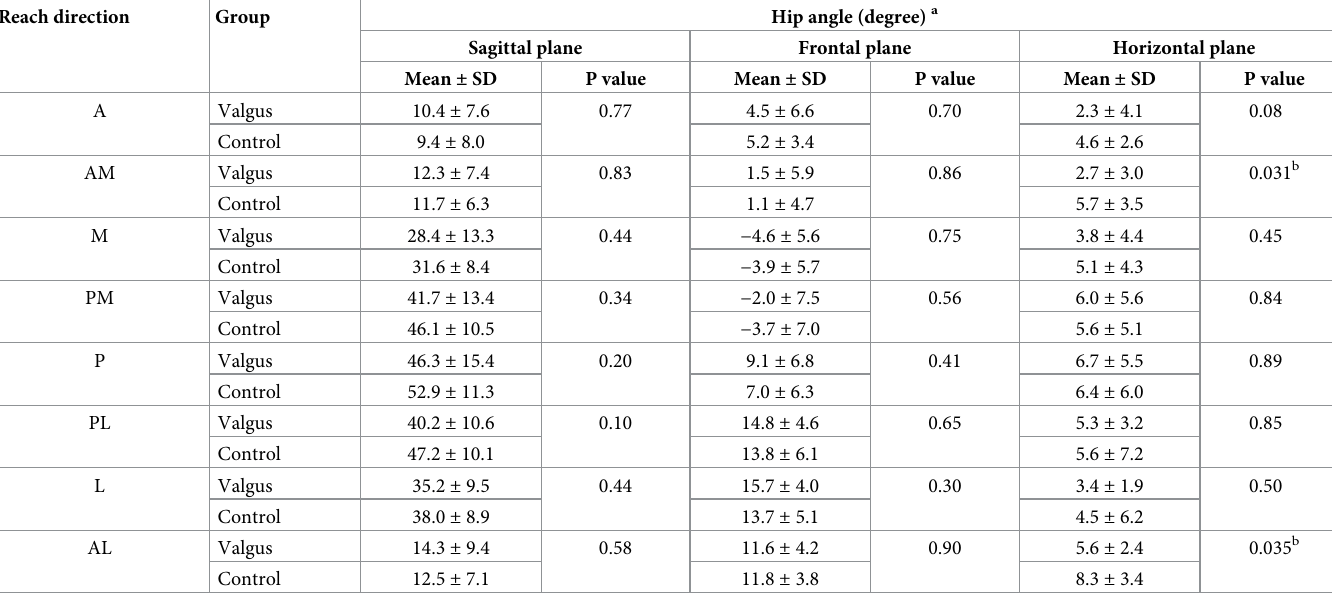
Table 4. The results of hip angle in all reach directions during Star Excursion Balance